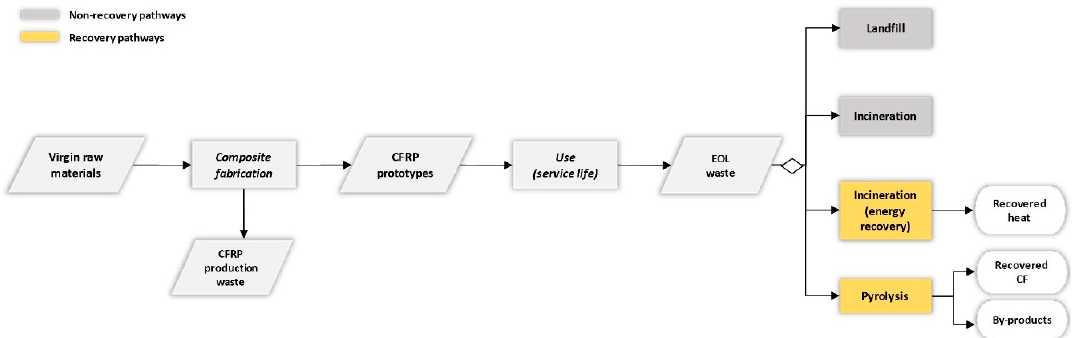
Figure 2. System boundaries considered for both CFRP prototypes: the SleekFast sailing boat and the handbrake lever. EOL, end-of-life.